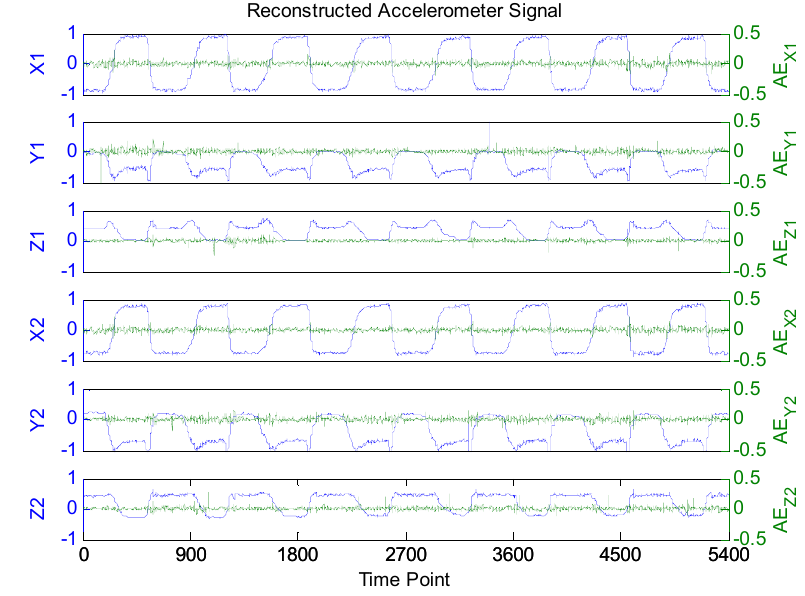
Figure 6. Reconstructed accelerometer signals and absolute errors (AE).